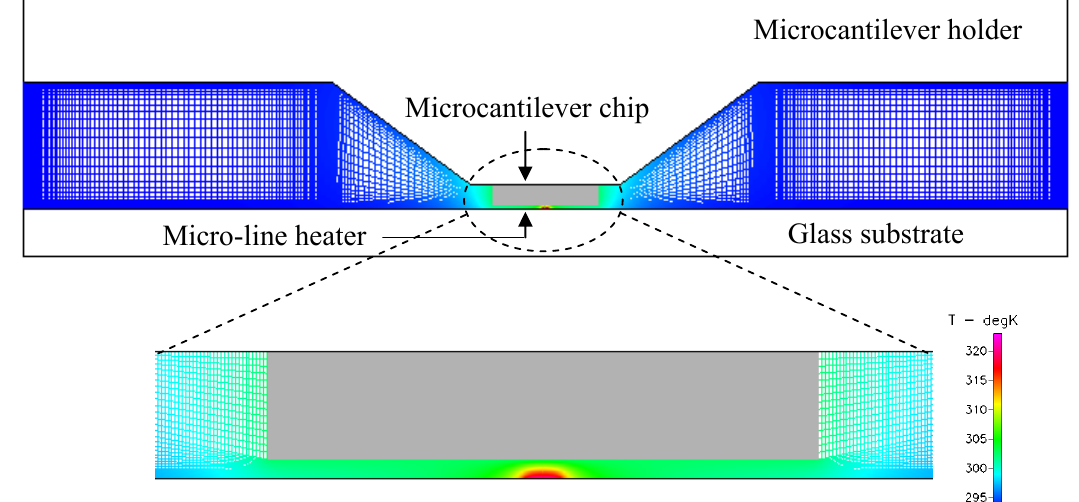
Figure 4. Two-dimensional computational simulation domain of the microscale thermal environment and the detailed prediction of the temperature